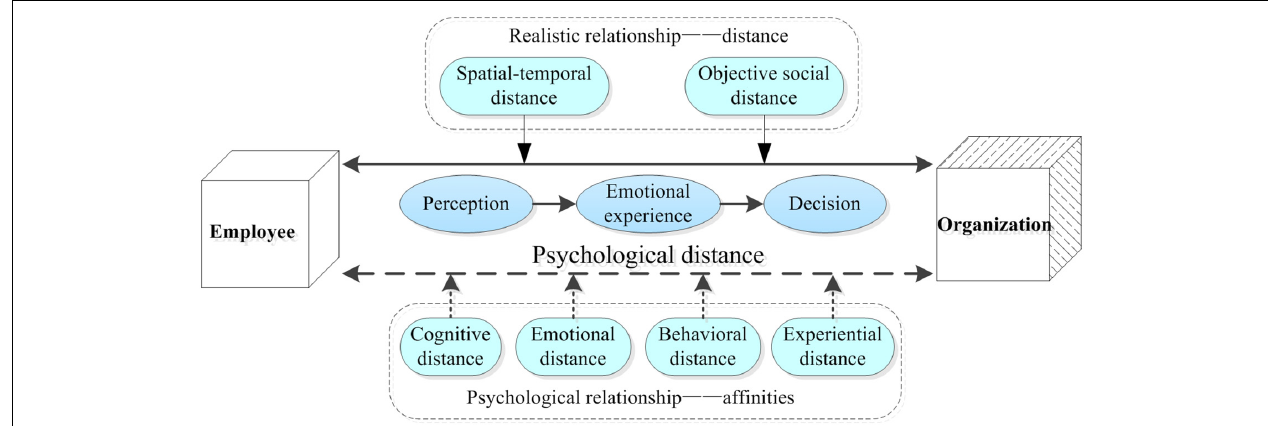
FIGURE 1 | Analytical graph of employee–organization psychological